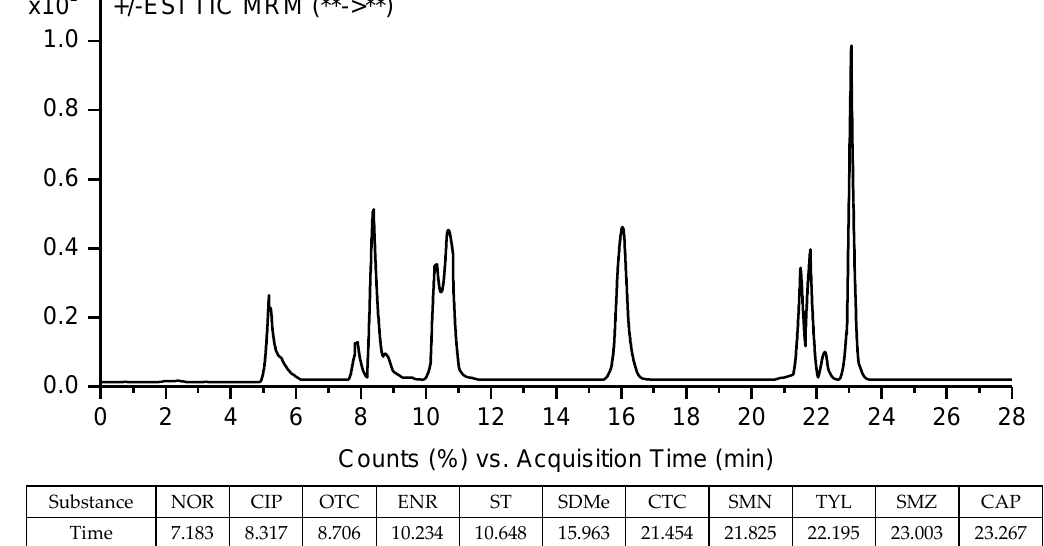
Figure 5. TIC chromatograms of a sample of extracted vegetable spiked (10 μg/g) with the selected 11